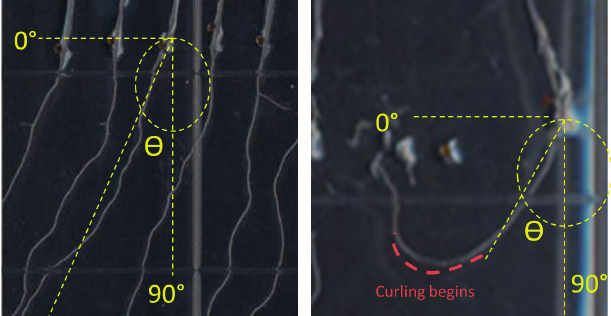
Figure A4. Root skewing measurement methodology. The etched grid on the back of square petri plates served as a reference point for assigning the vertical and horizontal vectors. Growth vectors were measured by drawing a line along the general axis of root growth. For curling roots, the growth vector was determined before the point at which the root begins to